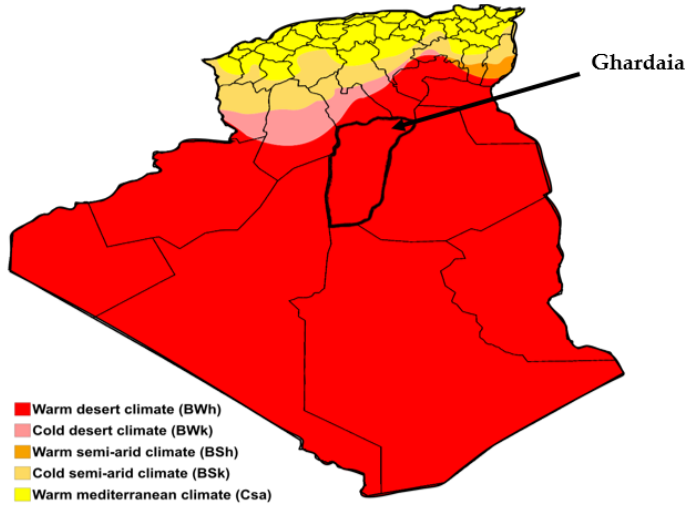
Figure 1. Map of Algeria showing the location of Ghardaia and the main climatic zones according to Koppen-Geiger climate classification [40].